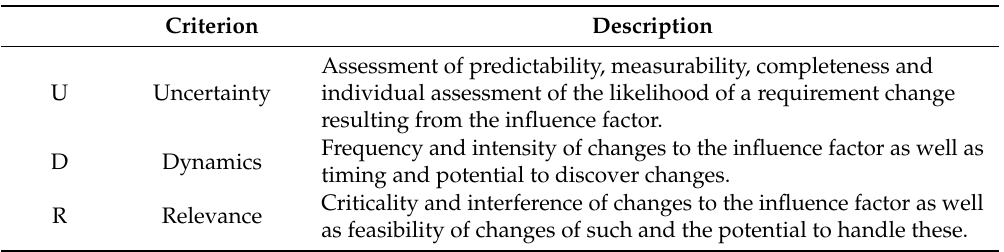
Table 2. Description of